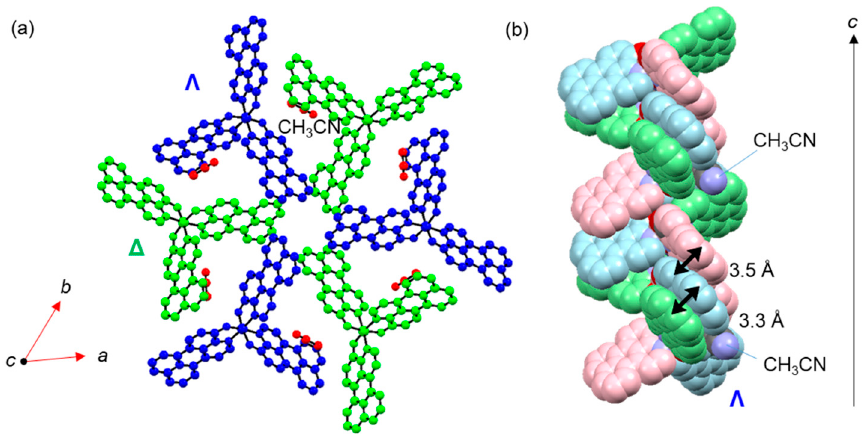
Figure 3. X-ray crystal structure of Al( L1 ) 3 . ( a ) Two-dimensional honeycomb-type packing in the ab -plane and ( b ) one-dimensional π -stacks along the c -axis within the crystal. Thermal ellipsoids are shown at 50% probability.